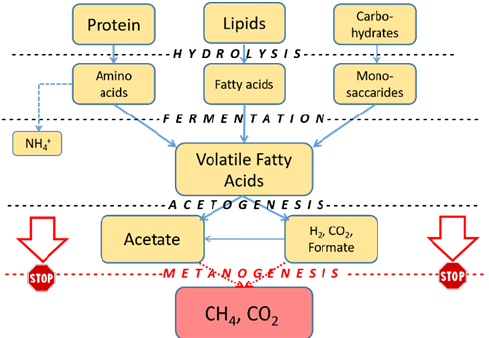
Figure 3. Anaerobic fermentation steps. By suppressing methanogenesis, VFAs and hydrogen could be recovered from the process. be recovered from the